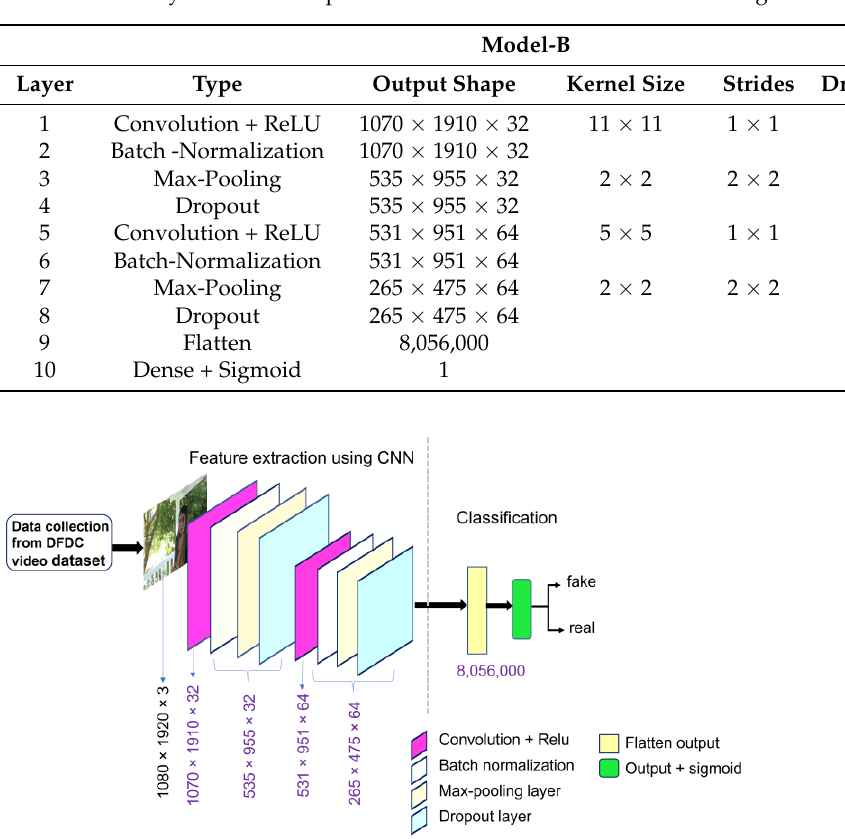
Figure 3. Proposed CNN architecture of Model-B for detecting deepfake